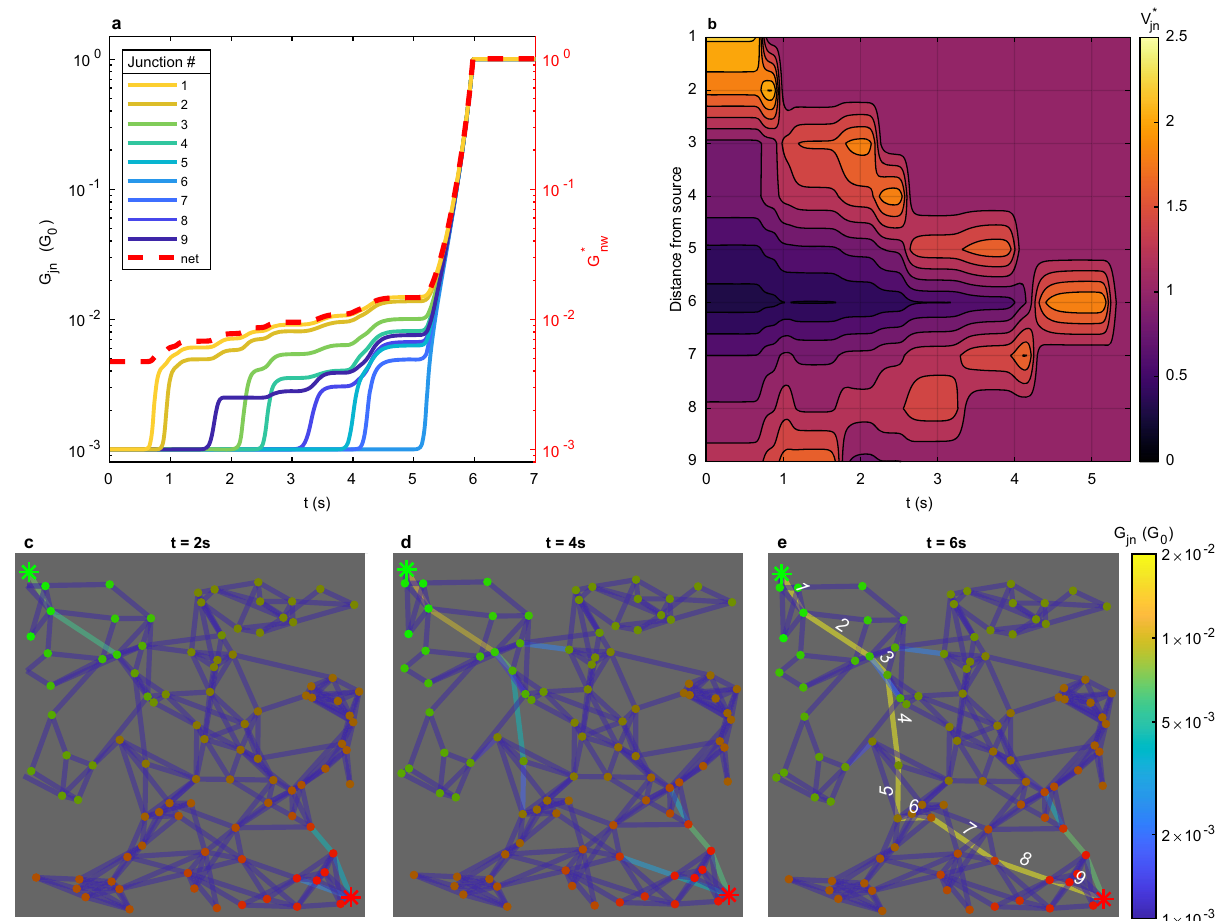
Fig. 3 Collective switching dynamics under DC bias. Simulations using a 100 nanowire, 261 junction NWN at voltage V * = V / V th = 1.1. a Conductance states of each junction, G jn , along shortest source-drain path (in units of conductance quantum G 0 ). Junctions are numbered sequentially according to ð t Þ (normalised by source-drain path length), is also shown. b Corresponding distance from source ( # 1 closest, # 9 farthest). Network conductance, G (cid:3) nw ¼ V = V – e Snapshots of G junction voltage, V (cid:3) jn distribution (edges shown on a logarithmic colourbar scale) at different jn set , dynamical re-distribution. c jn time-points during network activation. Node colour indicates voltage on nanowires between source (green asterisk) and drain (red